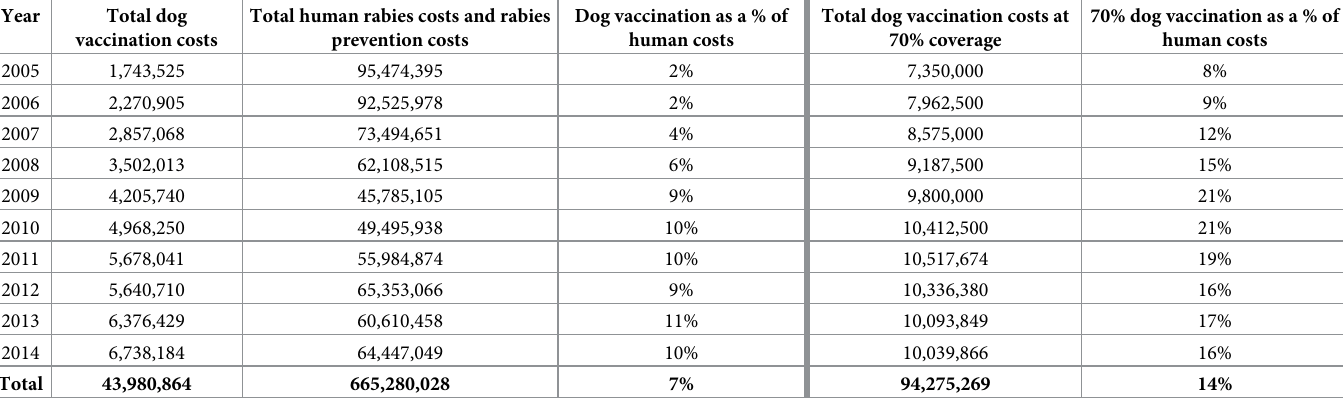
Table 12. Costs (in 2017 USD) associated with human rabies prevention in dogs as compared to rabies prevention and death at the actual dog vaccination coverage rate and at the recommended 70% dog vaccination coverage. Year Total dog vaccination